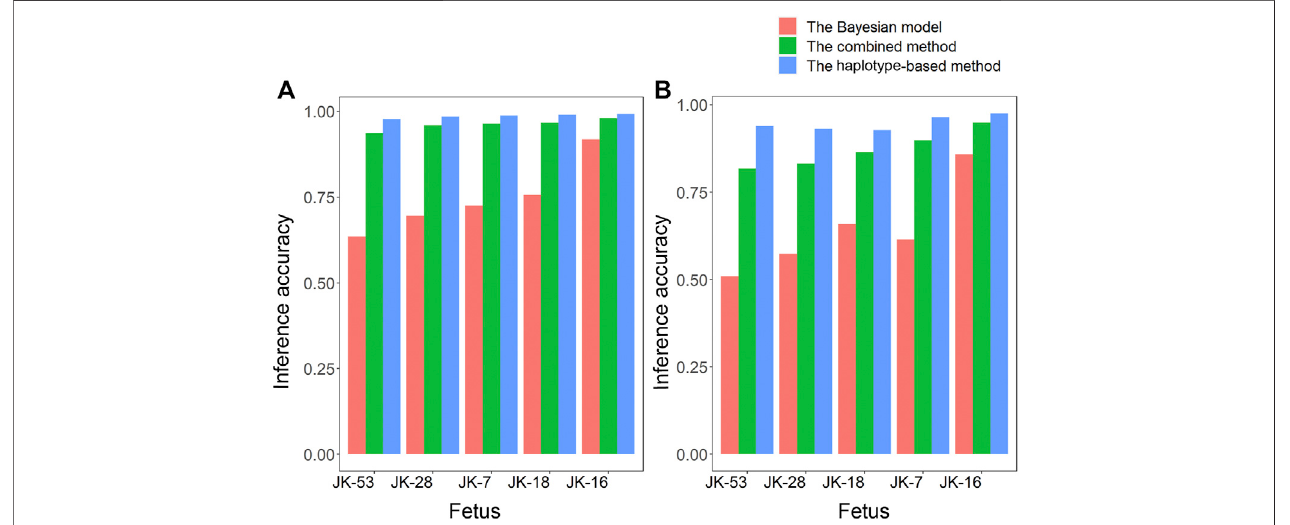
FIGURE3| Comparisonofhowaccurately fetalgenotypeswereinferred usingtheBayesian modelalone,thehaplotype-basedmethod alone,orthetwomethods together for (A) ABAA and (B) ABAB loci.